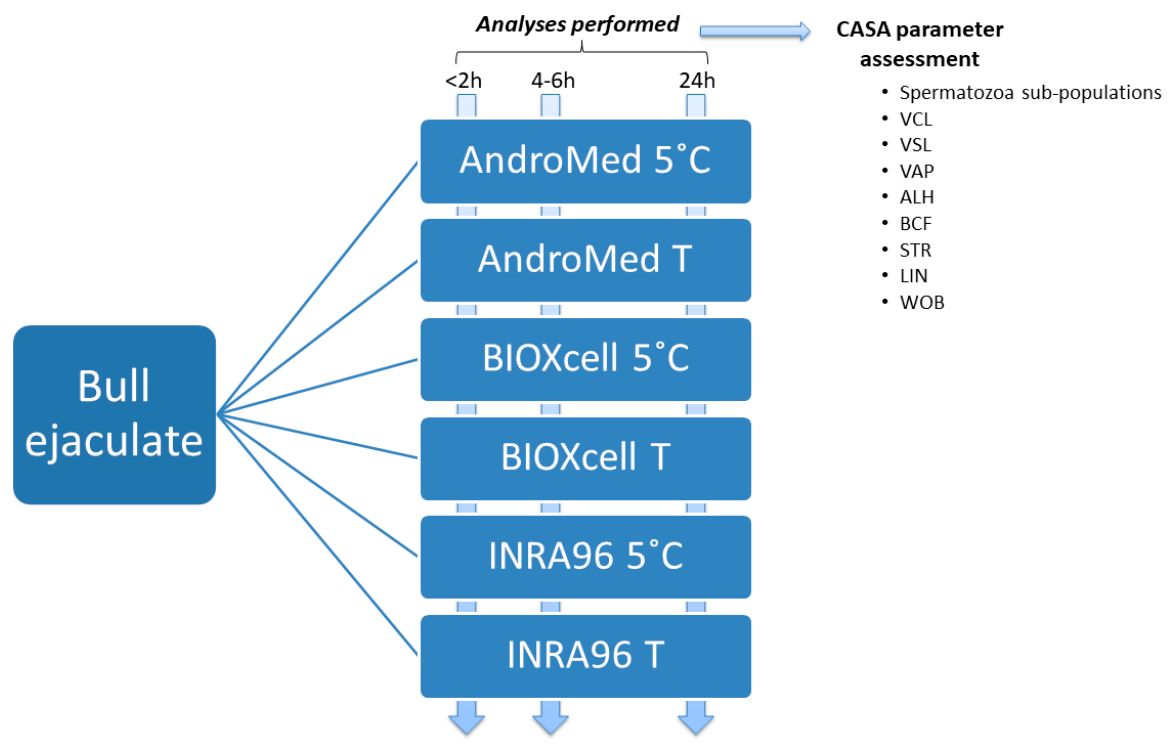
Figure 1. Experimental design (3 × 3 × 2: three extenders, three storage times, by two holding temperatures) and description of laboratory assessments.Abbreviations: T: room temperature; CASA: computer assisted semen analysis; VCL: curvilinear velocity, μ m/s; VSL: straight velocity, μ m/s; VAP: average path velocity, μ m/s; ALH: amplitude of lateral head displacement, μ m; BCF: beat cross frequency, Hz; STR: straightness (VSL/VAP); LIN: linearity (VSL/VCL); and WOB: wobble coefficient (VAP/VCL).